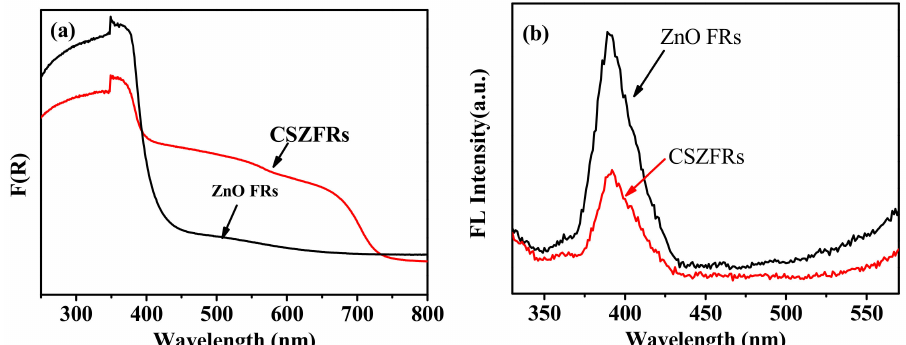
Figure 3. ( a ) UV-Visible diffuse reflectance spectra and ( b ) Fluorescence spectra of CSZFRs and ZnO